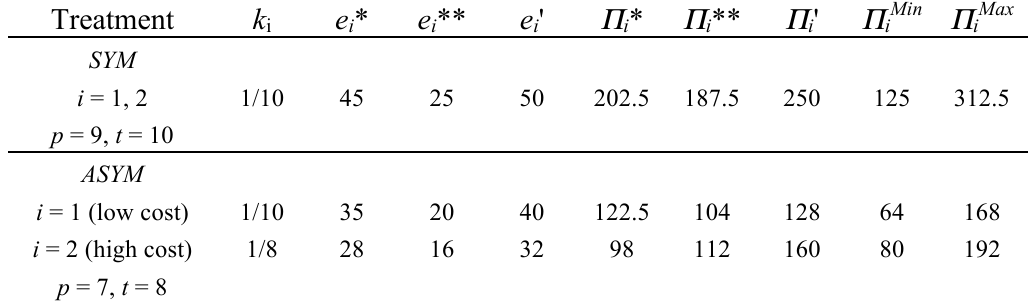
Table 1. Parameter values and theoretical predictions for the second stage of the game.